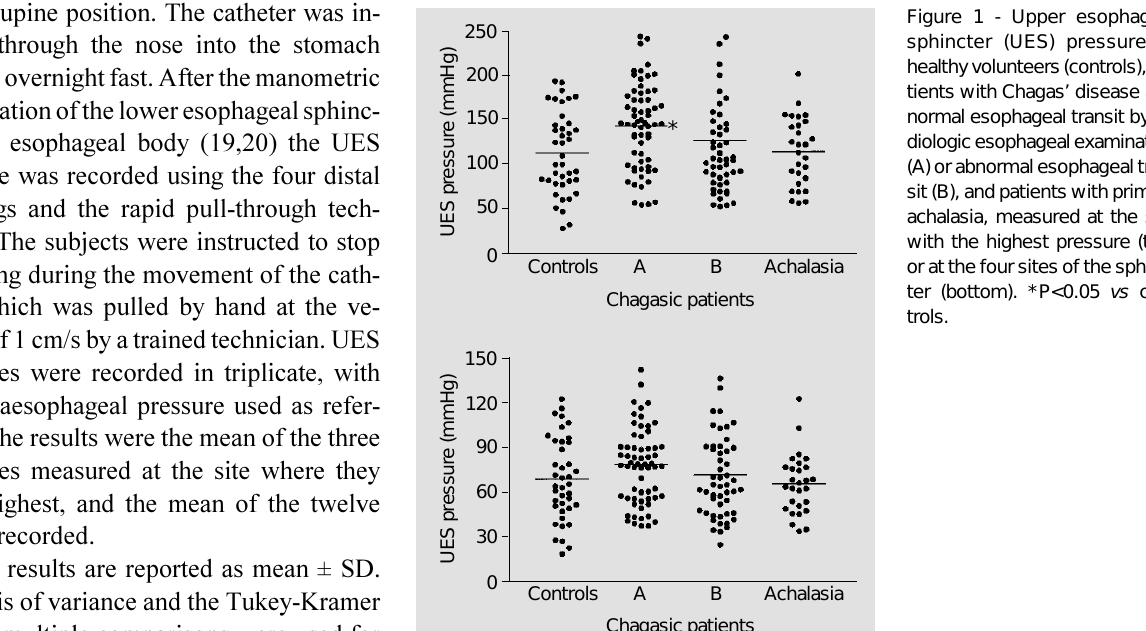
Figure 1 - Upper esophageal sphincter (UES) pressure of healthy volunteers (controls), pa- tients with Chagas’ disease and normal esophageal transit by ra- diologic esophageal examination (A) or abnormal esophageal tran- sit (B), and patients with primary achalasia, measured at the site with the highest pressure (top) or at the four sites of the sphinc- ter (bottom). *P<0.05 vs con- trols.